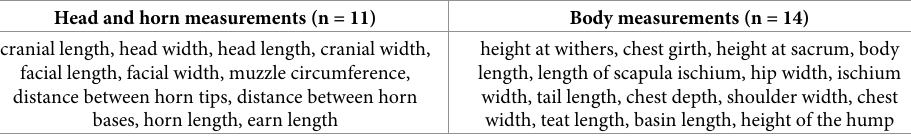
Table 2. List of measured quantitative traits. Head and horn measurements (n = 11) Body measurements (n = 14) height at withers, chest girth, height at sacrum, body cranial length, head width, head length, cranial width, facial length, facial width, muzzle circumference, length, length of scapula ischium, hip width, ischium distance between horn tips, distance between horn width, tail length, chest depth, shoulder width, chest bases, horn length, earn length width, teat length, basin length, height of the hump